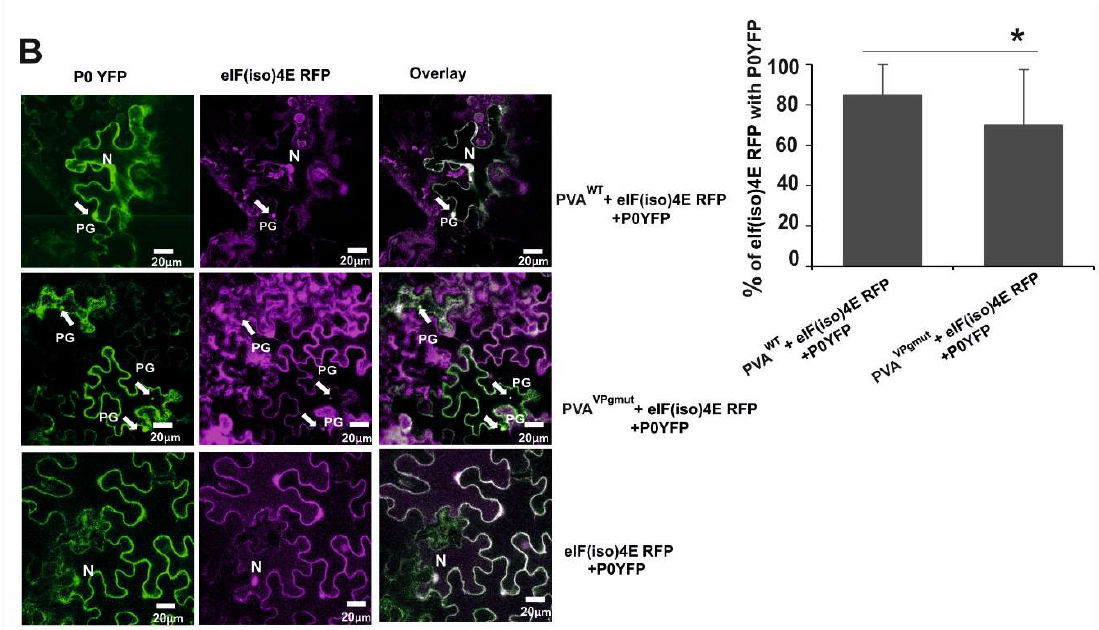
Figure 6. PGs formed in the presence of VPg mut contained reduced amounts of PVA RNA. ( A ) The binding of λ N22 RFP to the bacteriophage λ B-box RNA elements within the 3´UTR of PVA ∆ GDD RNA enabled the visualization of PVA RNA in vivo. PGs were induced by PVA ∆ GDDB-box and visualized by P0 YFP (green channel) and λ N22 RFP (magenta channel). The RFP signal was mainly found in the nucleus (indicated by N) due to the nuclear localization signal that was present in λ N22 RFP , but it was also found in the cytoplasm and PGs if bound to PVA ∆ GDDB-box RNA. The images are projections of Z-stacks with PGs indicated by arrows. Scale bar: 20 µ m. The percentage of P0 and PVA ∆ GDDB-box RNA co-localization in PGs ( n = 22) was quantitated with the Image J program. ( B ) PGs were induced either by PVA WT or PVA VPgmut and visualized by P0 YFP (green channel) and eIF(iso)4E RFP (magenta channel). Substantial co-localization between the YFP and RFP signals was observed. The images are projections of Z-stacks with PGs indicated by arrows. Scale bar: 20 µ m. The percentage of P0 and eIF(iso)4E co-localization in PGs that were induced by PVA WT and PVA VPgmut ( n = 47) was quantitated with the Image J program. A Student’s t -test shows the di ff erence between the samples; p -values < 0.05 are indicated with *, and p- values < 0.001 are indicated with